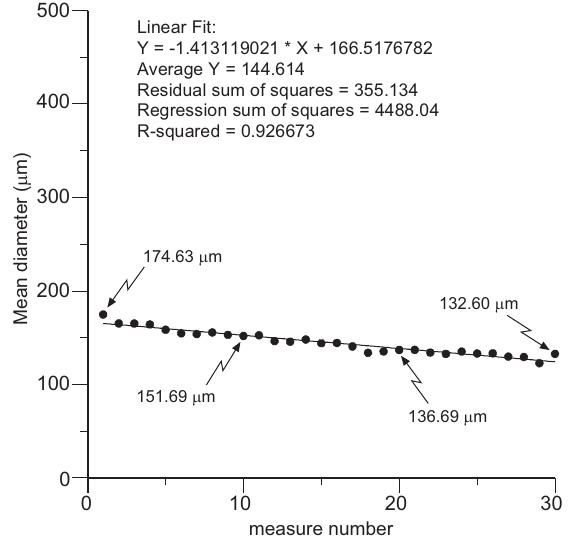
Fig. 13. Results of a measurement precision tests performed on sub- sample aliquot CABRE3k by the Cilas 930 laser diffraction particle size analyser; mean diameter value evolution with increasing the number of measurement runs. Data statistics are